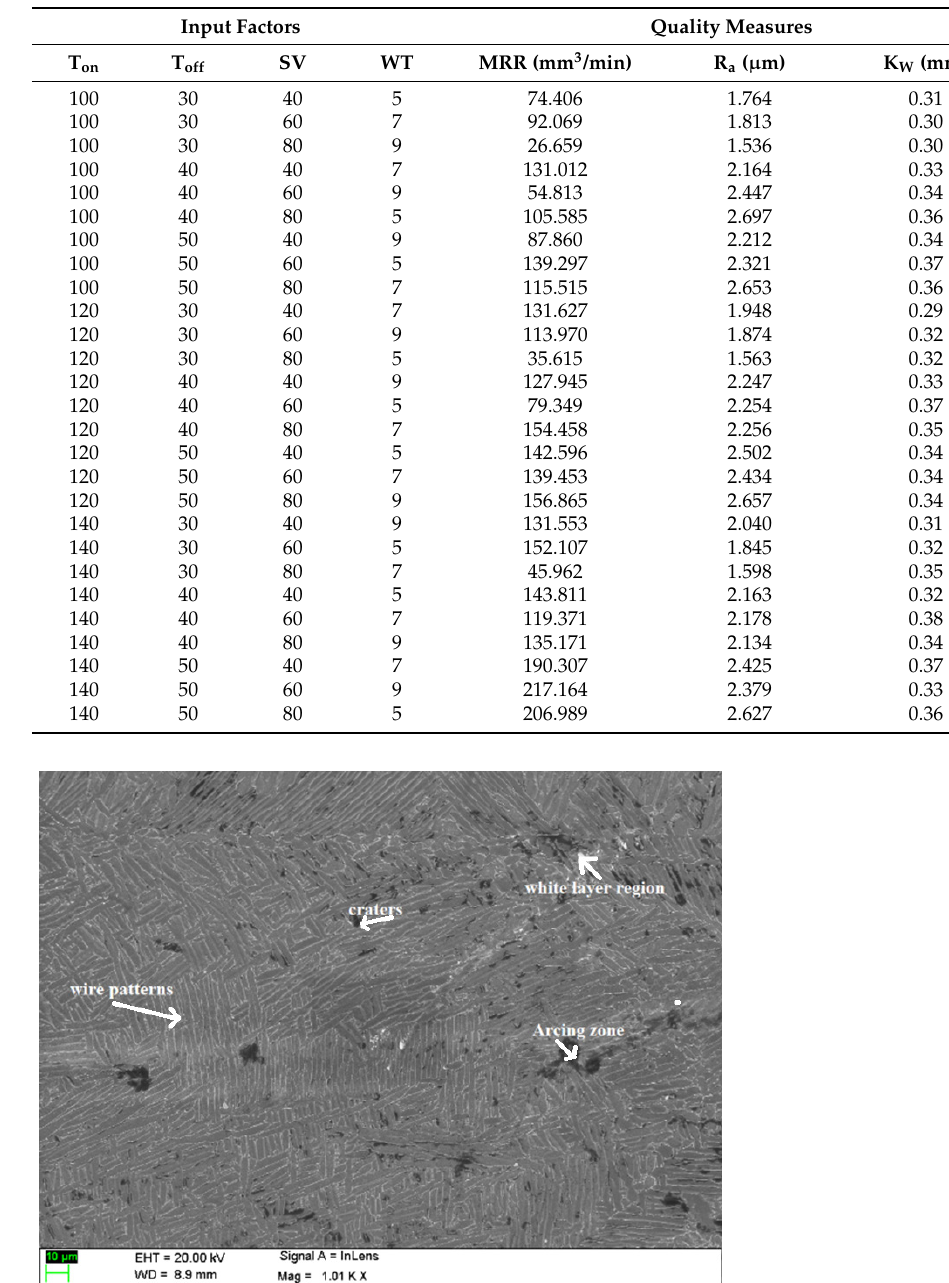
Figure 4. Machined surface of specimens in WEDM.